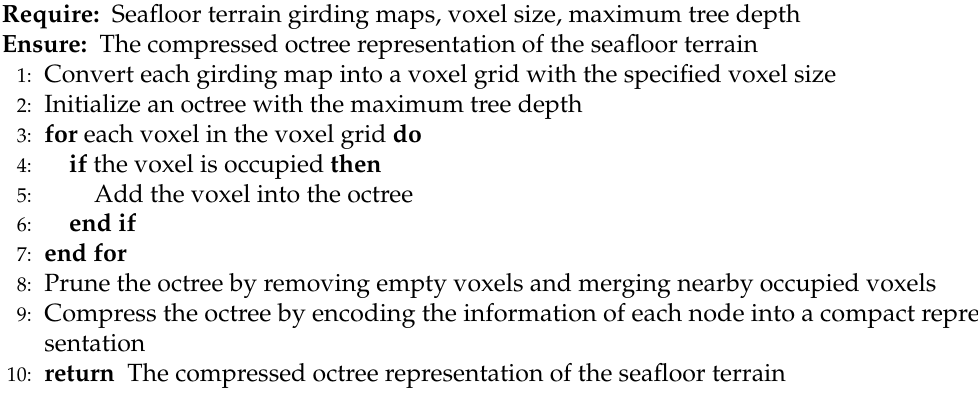
Algorithm 2 Octree spatial occupancy method for representing seafloor terrain girding maps